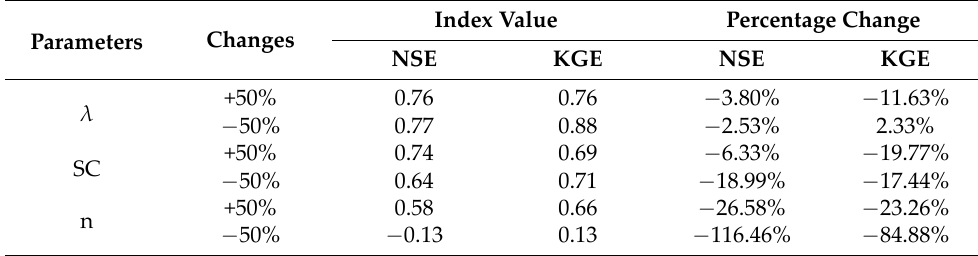
Figure 5. Comparison of the simulation performance derived from TMPH, TWBM, and ABCD for the selected years. Table 3. Sensitivity analysis of model